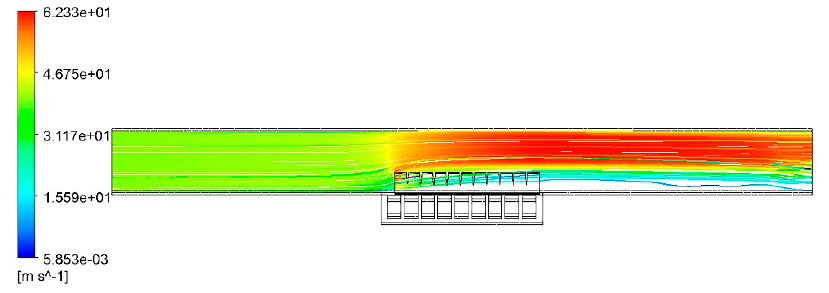
Figure 9. Velocity streamline of HTU air-side.